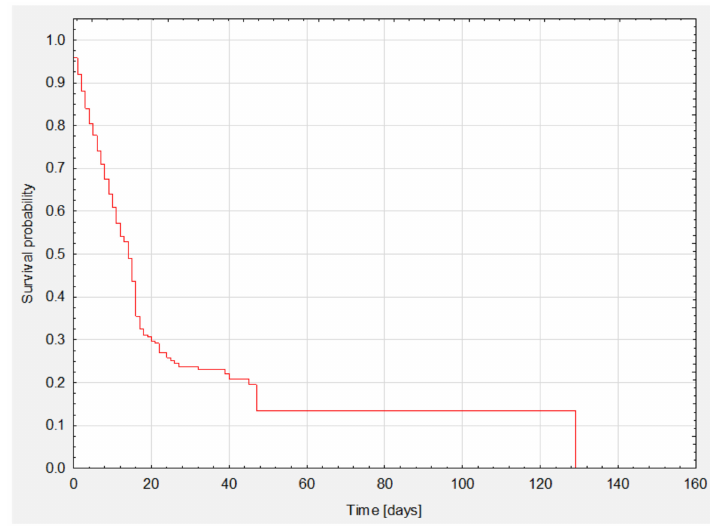
Figure 1. Analysis of survival of the whole group.